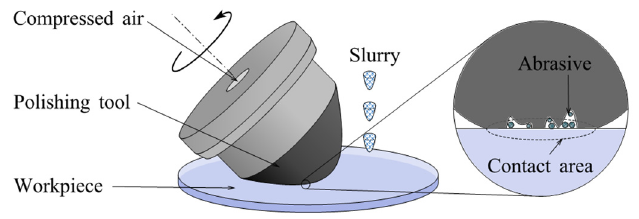
Figure 17. The schematic diagram of BP [135].